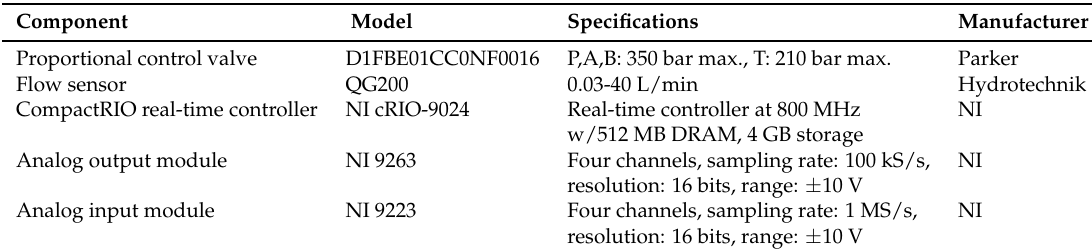
Table 1. Specifications of experimental EHVS.